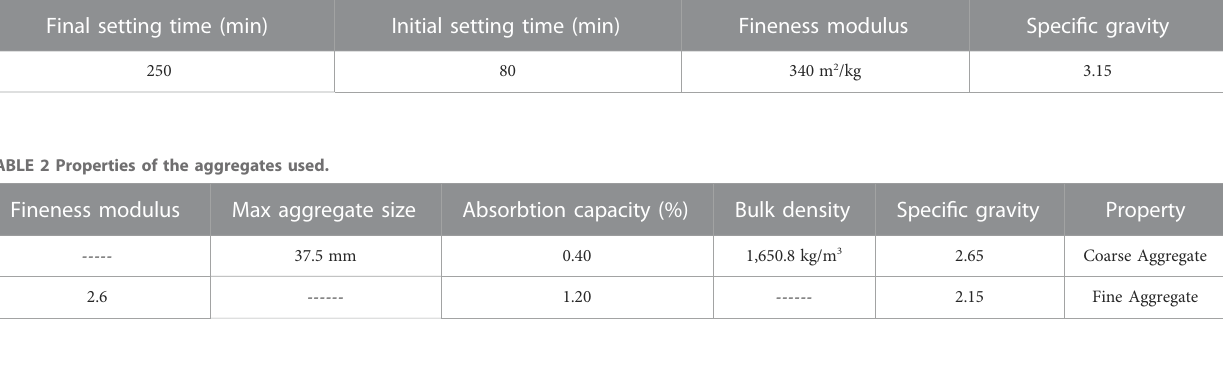
TABLE 3 Properties of corrugated fi bers.